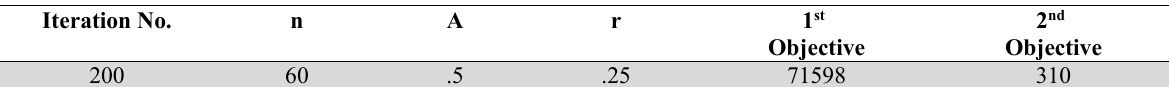
Parameter values of MOBA Pareto